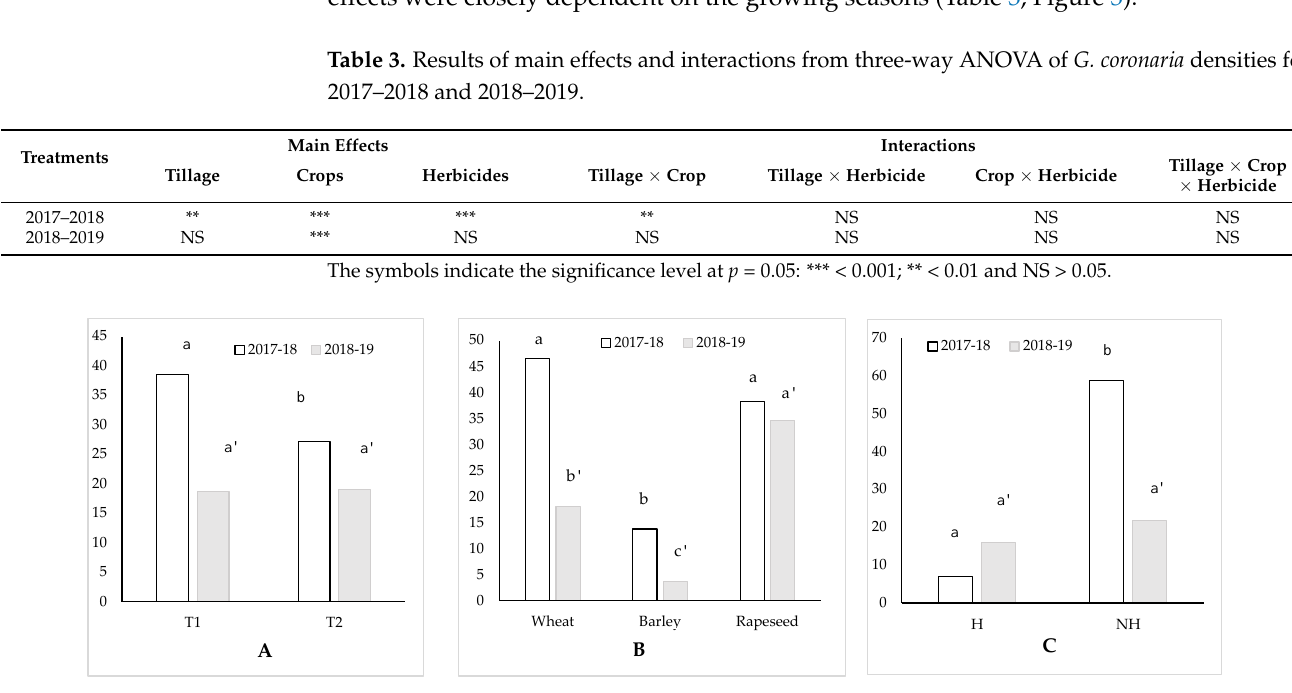
Figure 3. The effects of the management factors ( A ): tillage (T1 and T2); ( B ): Crops (wheat, Barley and Rapeseed); ( C ): herbicide applications (H and NH) on the density (plants/m 2 ) of G. coronaria determined at crop harvest in the two growing seasons, Same superscript letters (a, b and for 2017 – 2018; a ’, b’ and c’ for 201 8 – 2019) across treatments are statistically similar according to Duncan test ( p = 0.05).